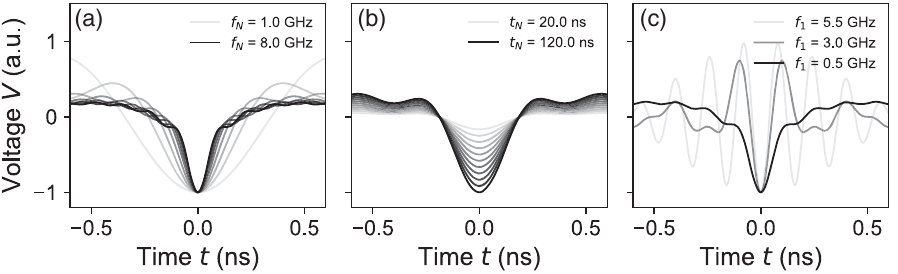
FIG. 12. Effect of design parameters. SAW shapes of impulse-response model for changing IDT parameters. (a) Varying maximal frequency f N with f 1 ¼ 0 . 5 GHz and t N ¼ 40 ns. (b) Increasing IDT length t N with f 1 ¼ 0 . 5 GHz and f N ¼ 3 . 5 GHz. (c) Reducing minimum frequency f 0 with f N ¼ 7 GHz and t N ¼ 40